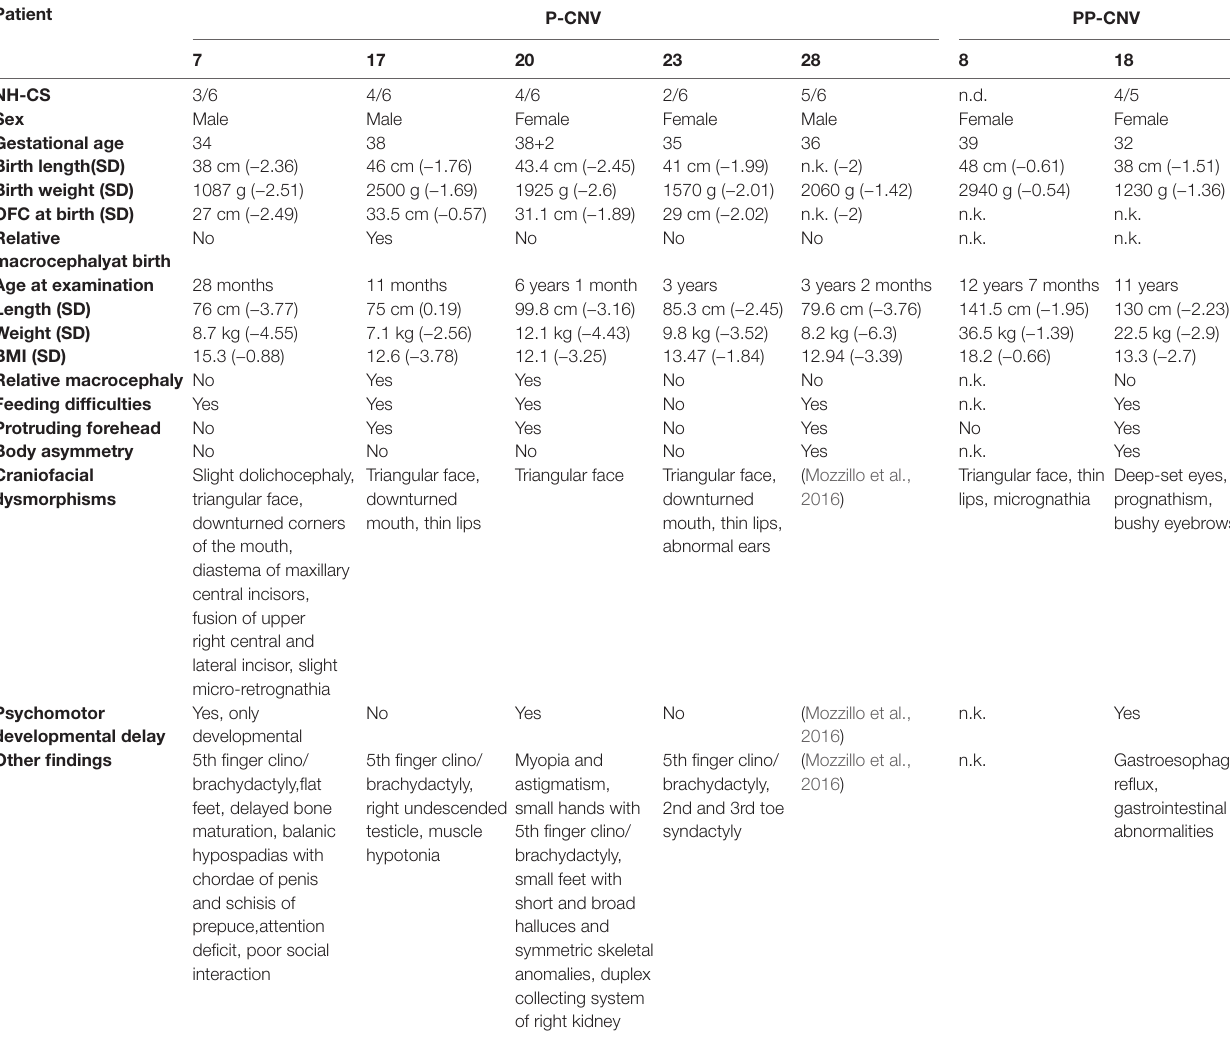
TABlE 3 | Clinical data of patients from the study cohort carrying pathogenic (P) or potentially pathogenic (PP) variants.